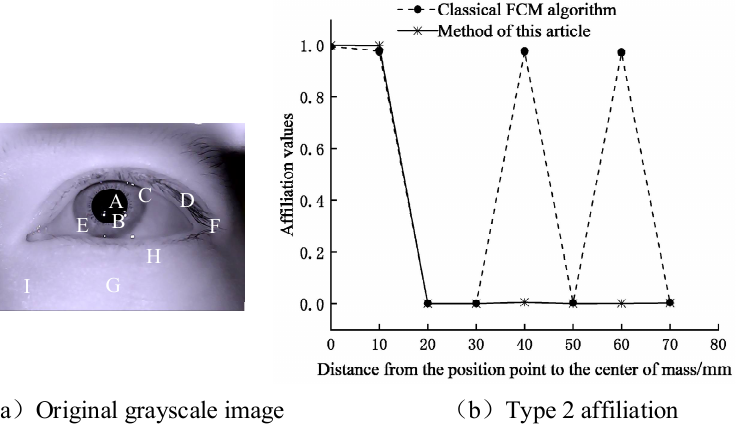
Figure 4. Comparison of the second type of affiliation at different locations. ( a ) Original grayscale image; ( b ) Type 2 affiliation. The second-class affiliation values of point A—point I obtained by the clustering algorithm in this paper, where points A and B are the points in the pupil area, and point C—point I are the points at different distances from the pupil region, and point D and point F in the non-pupil area have close intensity values to point A and point B .